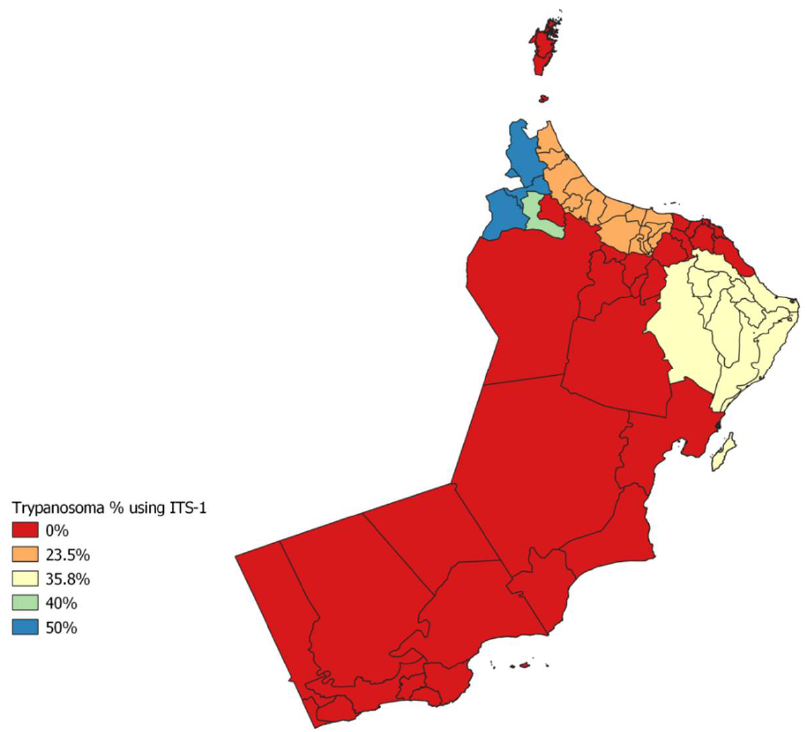
Figure 3. Distribution of trypanosomoses in camels in Oman by using ITS-1 (QGIS 7.4).